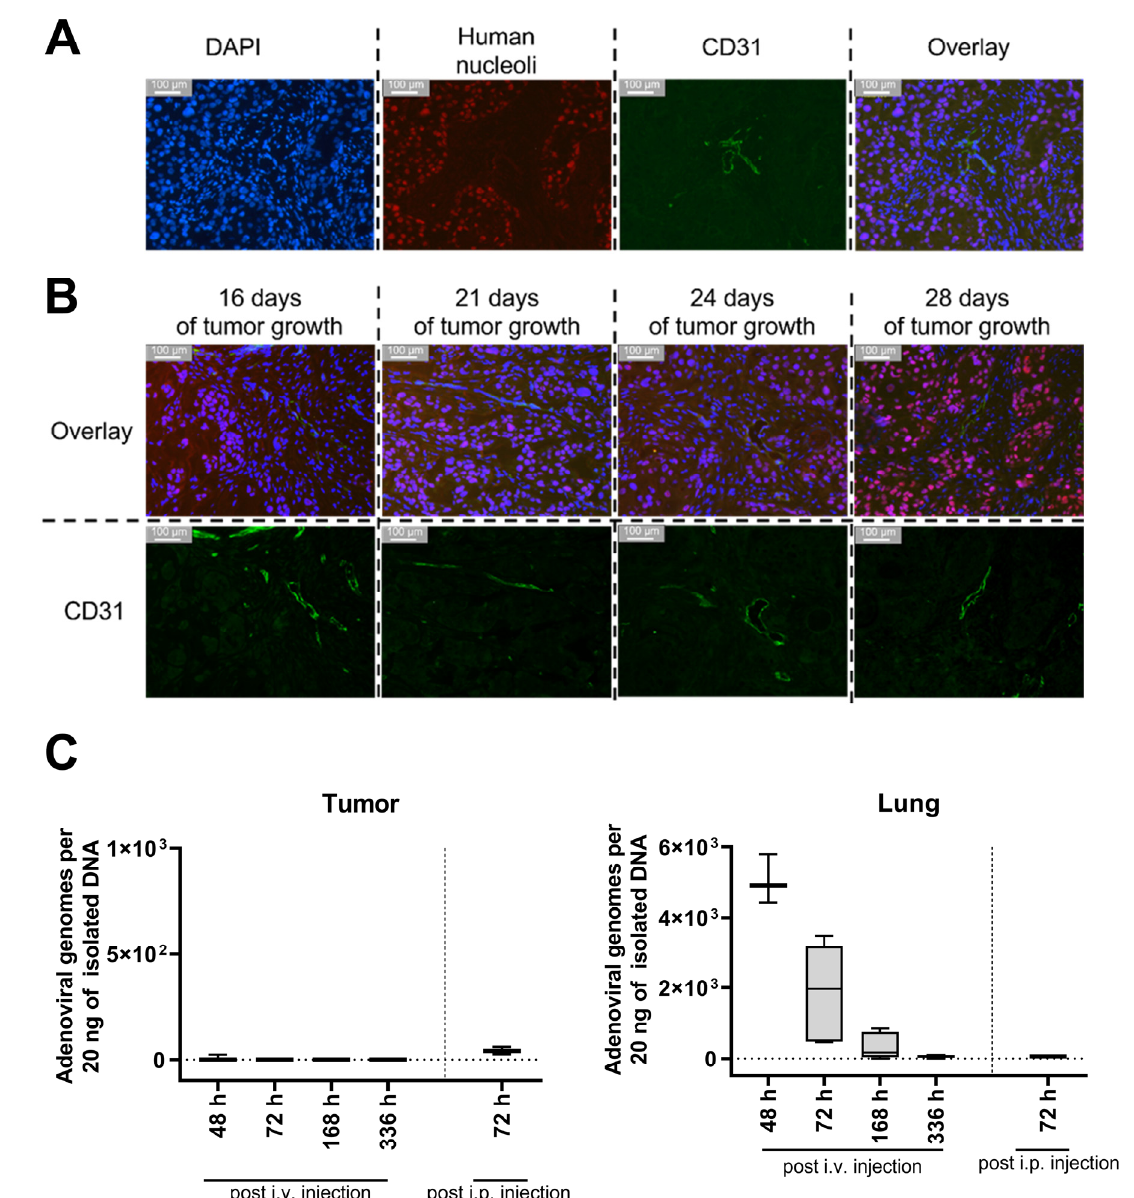
Figure 7. No adenoviral DNA was found in the xenograft tumor upon injection of BM-hMSCs transduced with a firefly luciferase-encoding HAdV-5 vector despite suitable tumor vascularization already 16 days after transplantation. ( A , B ) 6 µ m tumor sections were stained using a rat α -mouse CD31 and a mouse α -human nuclear antigen antibody combined with two secondary antibodies (goat anti-rat IgG coupled to Alexa fluor 488, goat α -mouse coupled to Alexa fluor 594). Cell nuclei were stained with DAPI. ( A ) Staining of UD-SCC-2 xenograft tumor after 21 days of tumor growth. ( B ) Staining of UD-SCC-2 xenograft tumors after different times of tumor growth. Overlay = DAPI + Human Nucleoli + CD31 ( C ) Genomic DNA was isolated from snap-frozen UD-SCC-2, and UD-SCC-6 tumors and lungs from xenograft-bearing NSG mice having been injected with transduced BM-hMSC and analyzed for the presence of adenoviral E4 gene copy numbers by qPCR. Since the hMSCs were transduced with a replication-incompetent first-generation HAdV-5 vector before injection, the presence of E4 in the isolated total DNA can be considered an indicator for hMSC infiltration. At 48 h: n = 3; 72 h: n = 6; 168 h: n = 4; 336 h: n = 5; i.p.: n = 3. Data of UD-SCC-2 and UD-SCC-6 and both injection time points were taken together, as no differences were